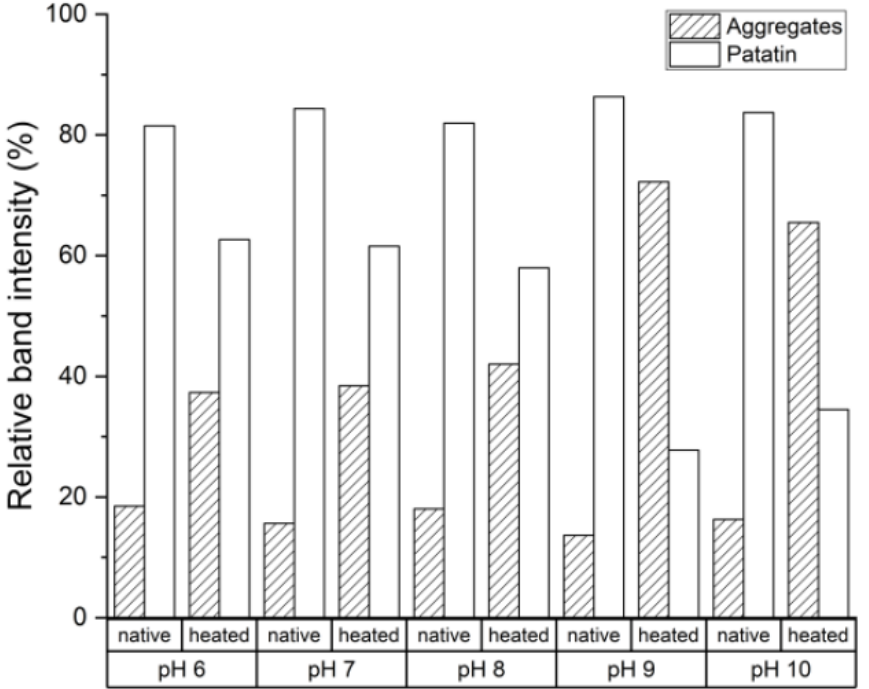
Figure 5. Influence of pH on the amount of native sized and aggregated patatin in dependence of the pH in a non-reducing SDS-PAGE. The heating was done 10 °C above T d for 30 min. The band intensity was taken from one SDS-PAGE gel under non-reducing conditions. For a better understanding of the protein interactions forming the aggregates, PPI solutions were mixed with the blocking substances sodium dodecyl sulfate (SDS), N- Ethylmaleimide (NEM), urea, and Tween 20. Upon heating, the relative intensity of the patatin and the aggregate fraction under non-reducing conditions changed (see Figure 6).